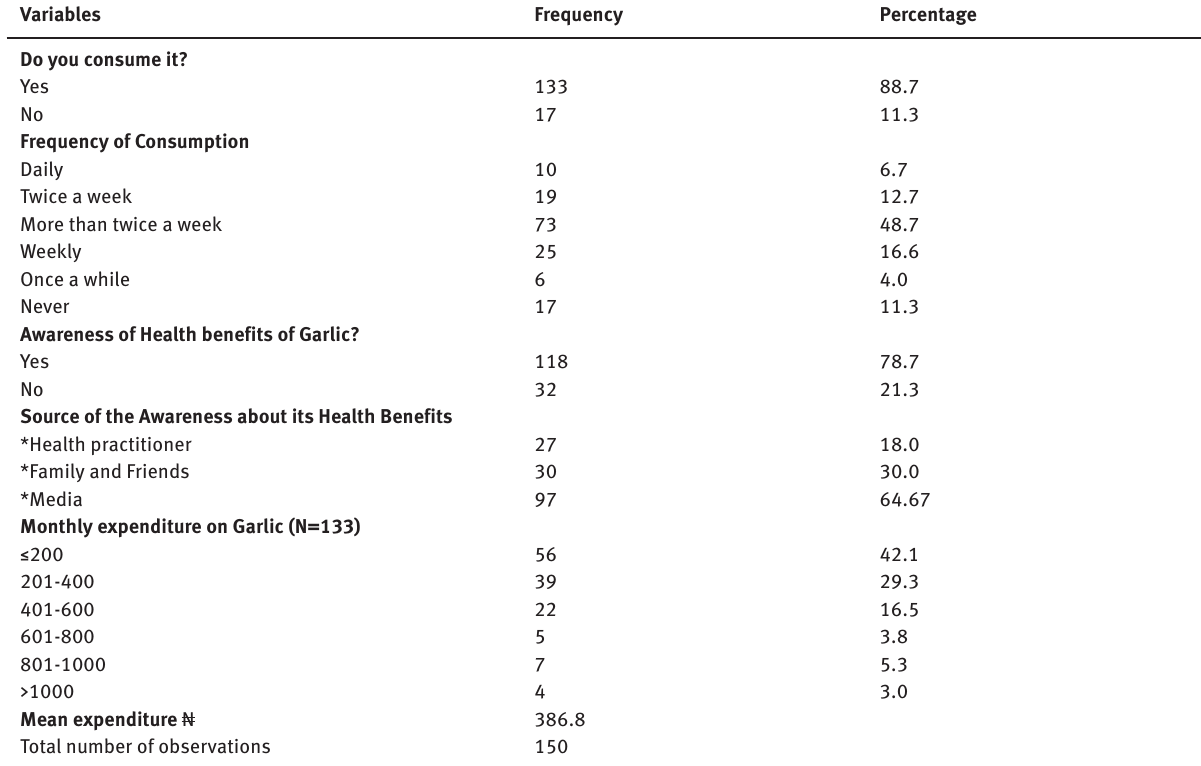
Table 2: Awareness and consumption patterns of garlic Variables